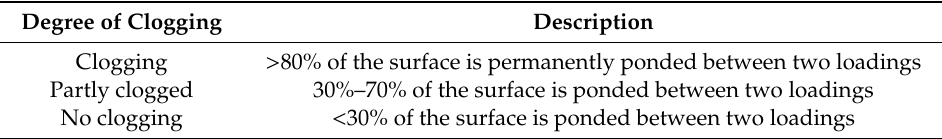
Table 7. Identification and classification of clogging (adapted from [13]).